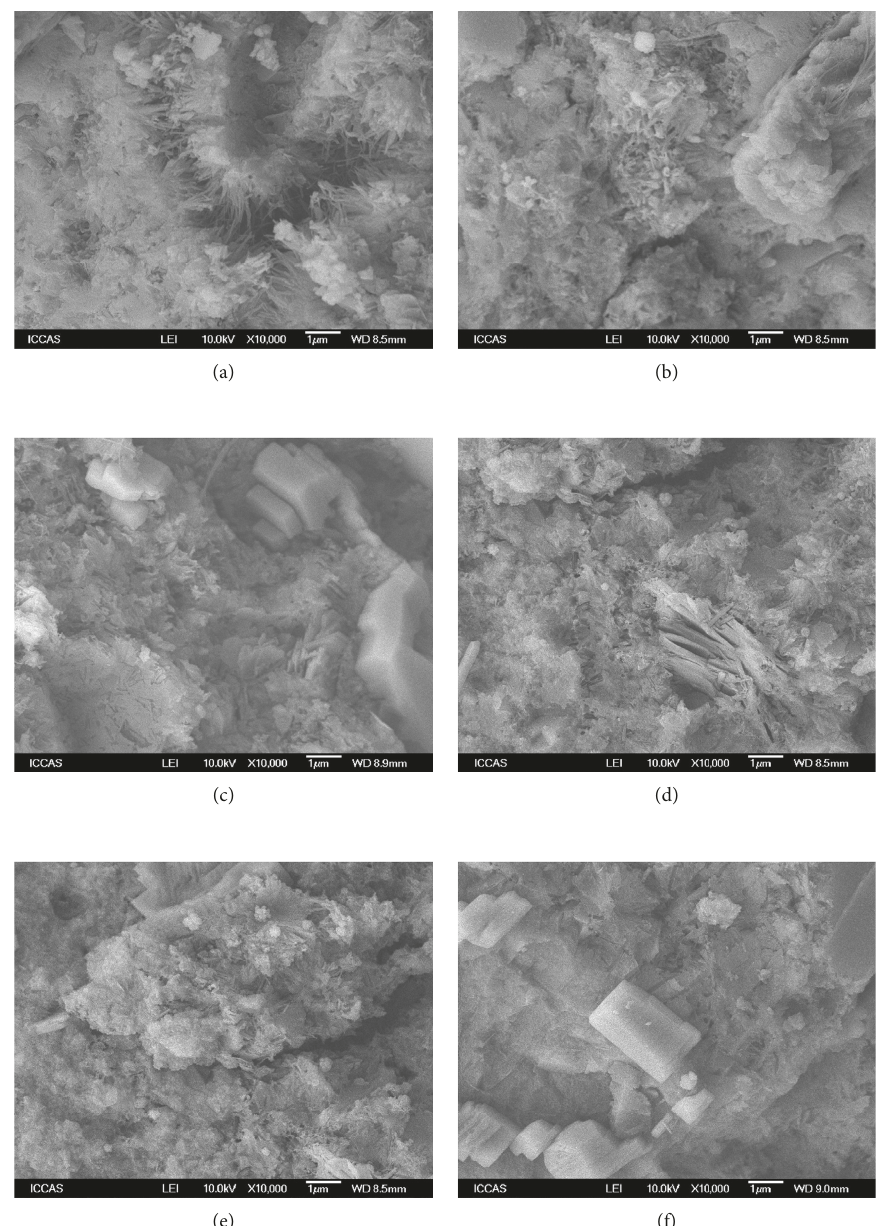
Figure 5: The hydration products morphology of different hardened cement at 28d. (a) Blank. (b) +0.05% EAC. (c) +0.05% DMO. (d) +0.05% TG. (e) +0.05% TMP. (f) +0.05%